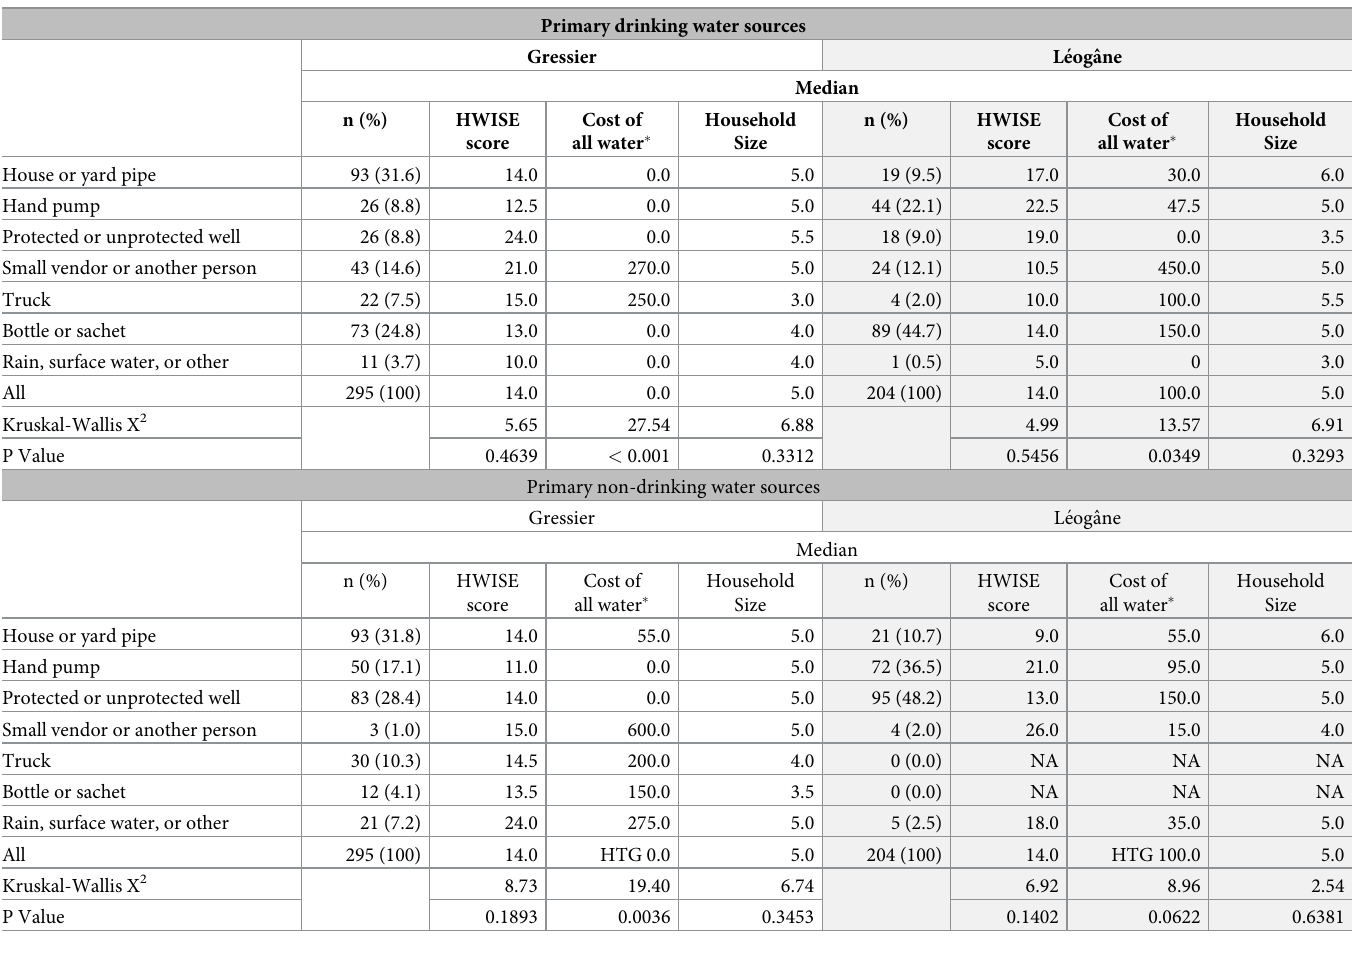
Table 3. Differences in numeric measures between water sources (Kruskall-Wallis